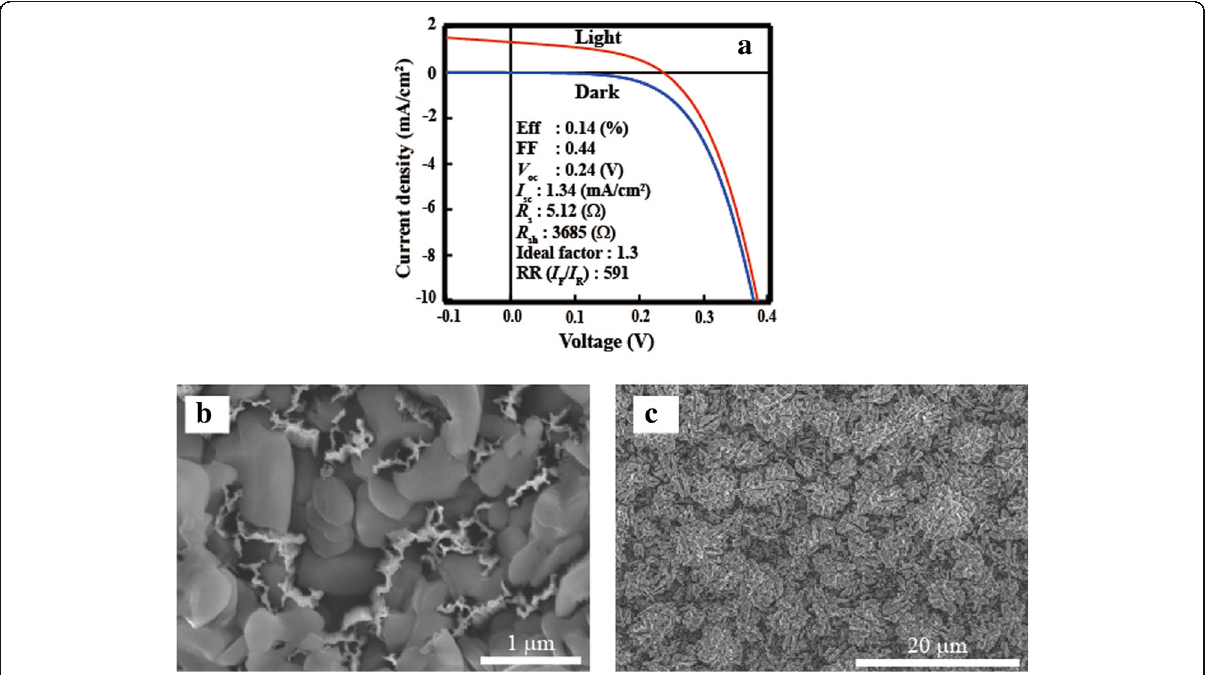
Fig. 5 a I – V characteristics of a SiNW solar cell with Al 2 O 3 removed using an etching paste. b High-magnification top view of the SEM image of SiNWs with